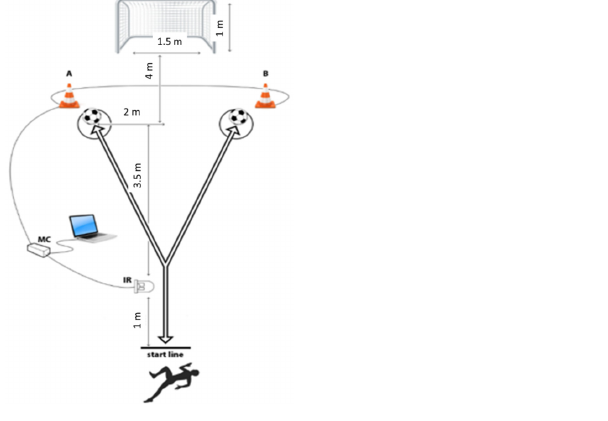
Figure 2. Testing of reactive agility and change of direction speed in football.